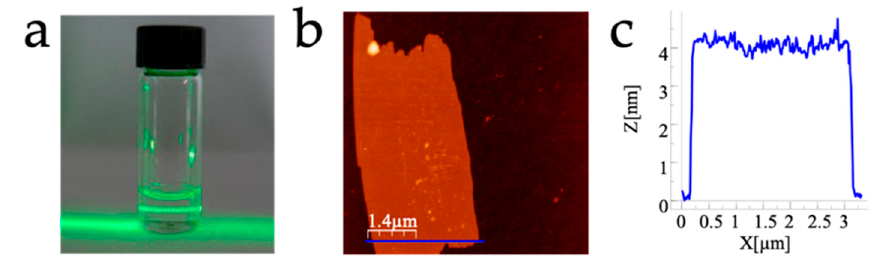
Figure 27. ( a ) Tyndall effect in compound 42 . ( b ) AFM image of a drop ‐ casted thin film of compound 42 . ( c ) Height profile of the thin film showed in ( b ).